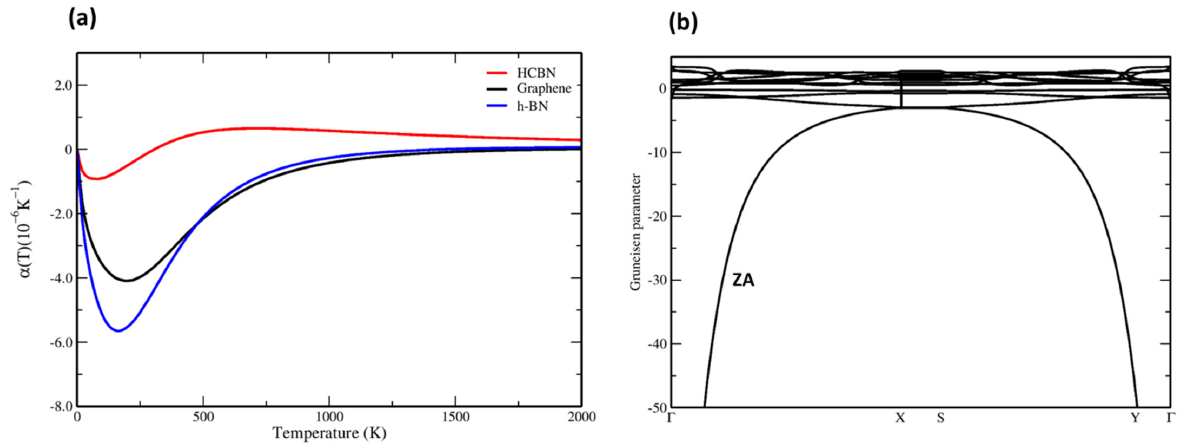
Figure 7. ( a ) LTECs for HCBN (red curve) compared with graphene (black curve) and h-BN (blue curve) ( b ) Grüneisen parameter for HCBN.